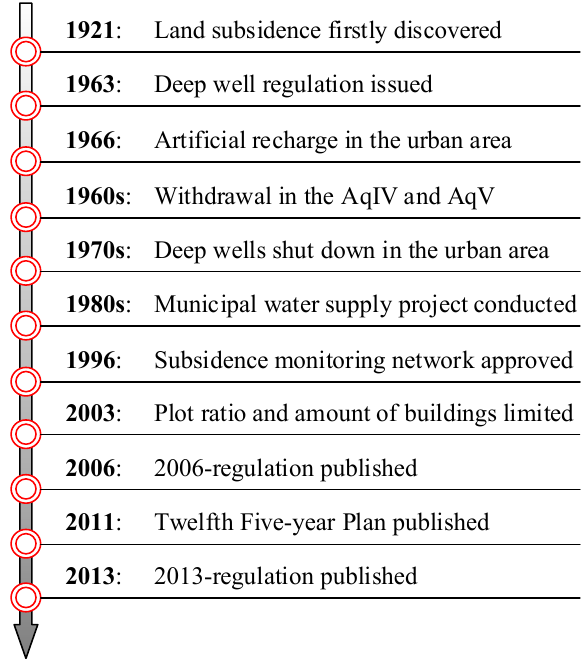
Figure 4. History of subsidence management in Shanghai (from 1920 to 2019).